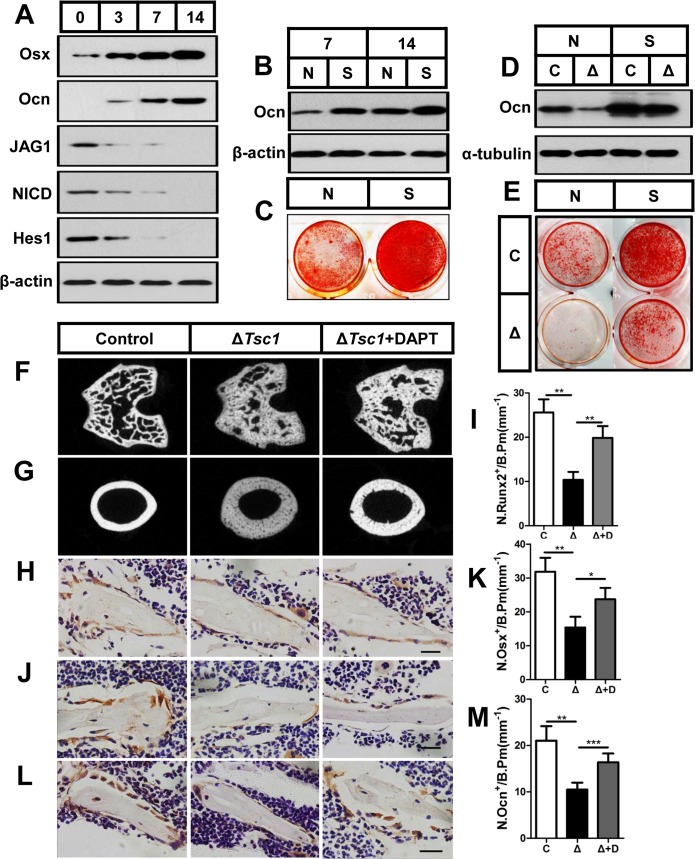
mTORC1 impairs osteoblast differentiation through the Notch pathway upstream of Runx2.(A) Western blot analysis of the expression of Jagged1, NICD and Hes1 during differentiation of MC3T3-E1 cells. Differentiating MC3T3-E1 cells were treated with Notch1 siRNA (S) and then underwent immunoblotting to detect osteocalcin (B) on the 7th and 14th day and alizarin red staining (C) on the 14th day. Differentiating control (C) and ΔTsc1 (Δ) primary calvarial cells were treated with negative control (N) or si-Notch1 (S) and then underwent immunoblotting to detect osteocalcin (D) and alizarin red staining (E) on the 14th day. 6-week old ΔTsc1 mice were administered with DAPT (10mg/kg per day) or equivalent volume of DMSO for 4 weeks, micro-CT images of trabecular bone in secondary ossification center (F) and cortical bone of midshaft (G) of femur were shown. Immunohistochemistry staining for Runx2 (H), osterix (Osx) (J), and osteocalcin (Ocn) (L) in distal femur. Numbers of Runx2 (N.Runx2+) (I), osterix (N.Osx+) (K) and osteocalcin (N.Ocn+) (M) positive cells on the bone surface were measured as cells per millimeter of perimeter in sections (/B.Pm). All data are mean ± SD (n = 5 mice), all scale bars represent 50 μm. *P < 0.05, ** P < 0.01, *** P < 0.001 by t test.